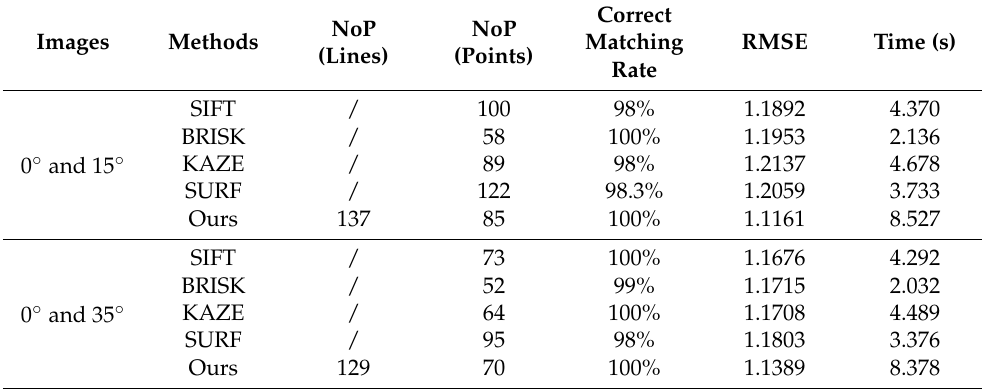
Table 2. The registration result comparison of the first scene.